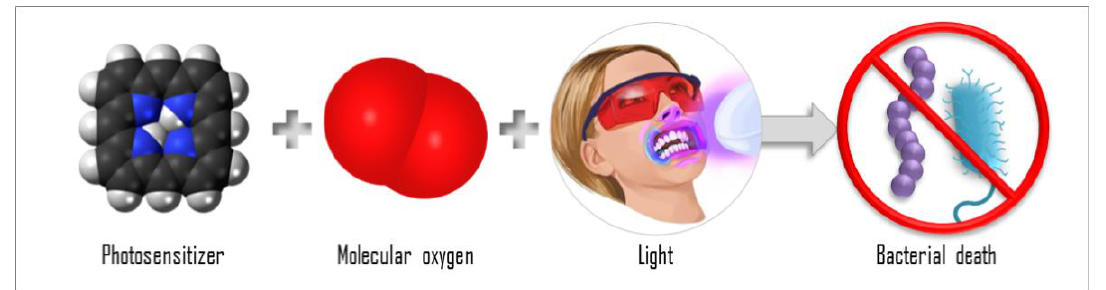
Figure 1. Scheme of the antimicrobial photodynamic therapy (aPDT) components: interaction of PS, molecular oxygen, and light, causing bacterial death.